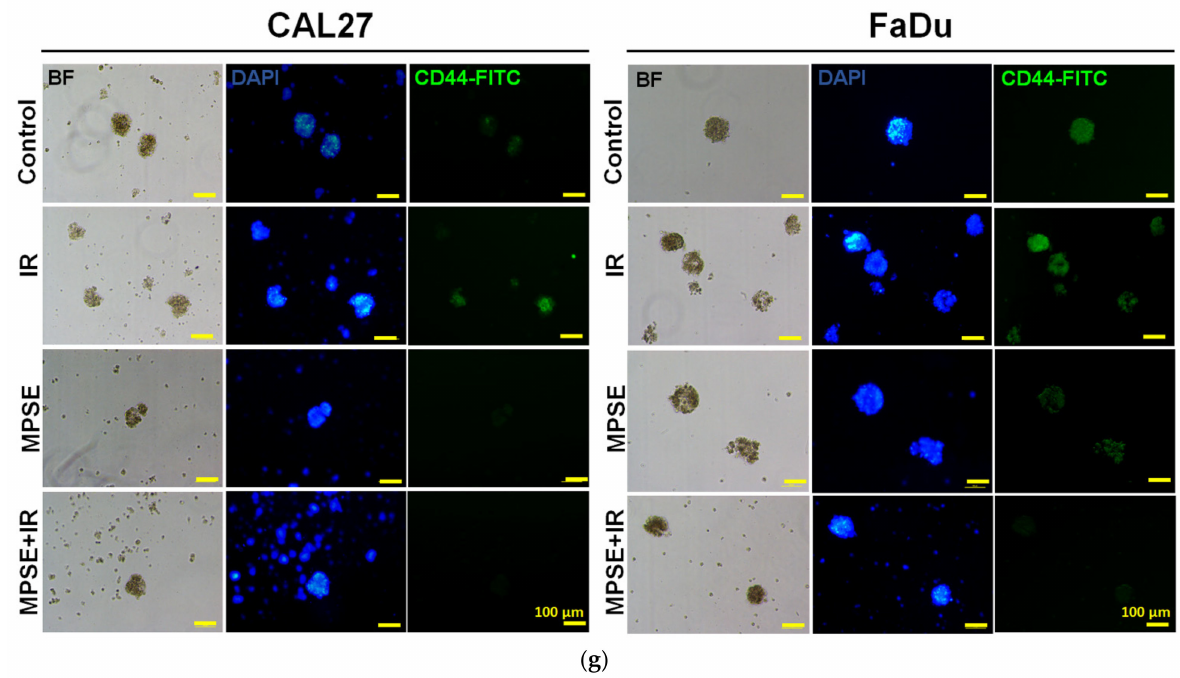
Figure 6. Pretreatment with MPSE or PGG before combining with irradiation suppressed the radiation-induced CSC phenotype in the HNSCC cell line. ( a ) Western blot analysis was performed to determine STAT3 phosphorylation in the indicated groups and ( b ) their band intensity was quantified. ( c , d ) CAL27 and FaDu cells were treated with either IR alone or the combination of 15 µ g/mL MPSE or PGG with 6 Gy IR X-ray for 24 h and then were resuspended and cultured to form spheroids. Tumorsphere growth was quantified by determining the spheroid area using ImageJ software on day 10 (bar, 100 µ m). ( e , f ) The percentages of head and neck cancer cell populations that expressed CSC markers (ALDH+). Data are presented as the mean ± SD of three independent experiments. ( g ) Immunofluorescence staining of the CSC marker (CD44) was determined in tumor spheroids. Statistical significance was evaluated by one-way ANOVA, followed by post hoc Tukey’s multiple comparison test (* p < 0.05). MPSE, Maprang seed extract. PGG, pentagalloyl glucose. HNSCC, head and neck squamous cell carcinoma. IR, irradiation. CSCs, cancer stem cells. ALDH, Aldehyde